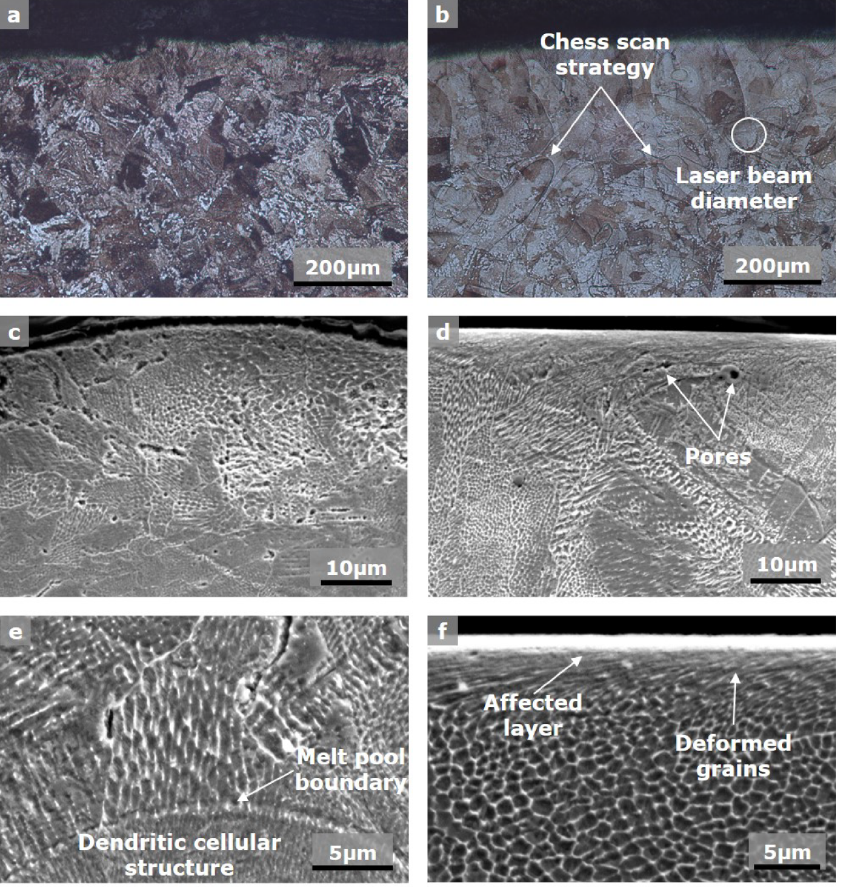
Figure 6. Micrograph of as printed (a, c, e), as burnished samples (b, d, f)